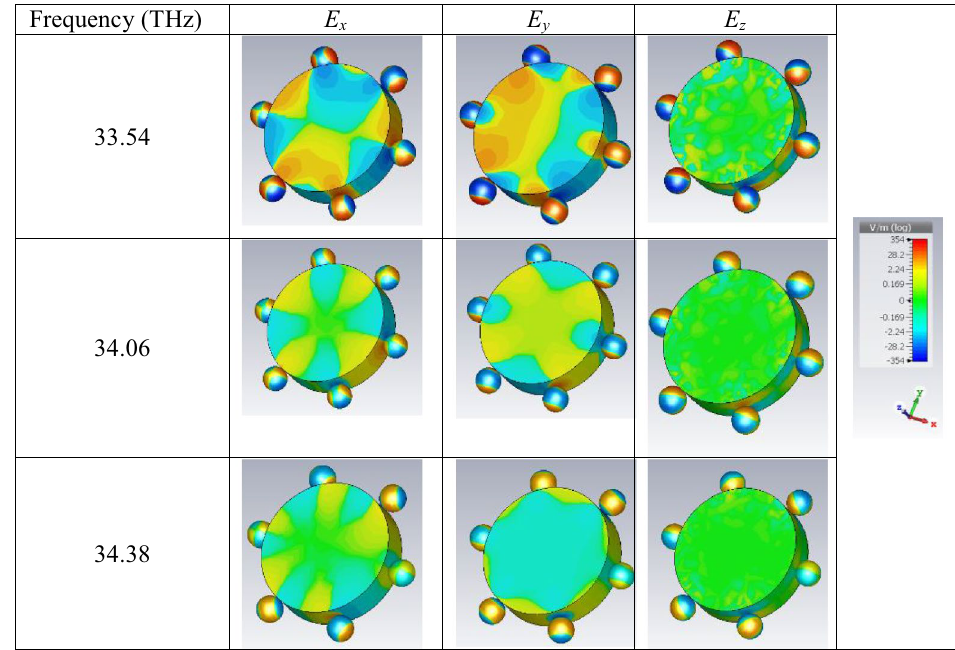
Table 1. Excited localized surface plasmons at the extinction peaks of the hexamer (Fig.